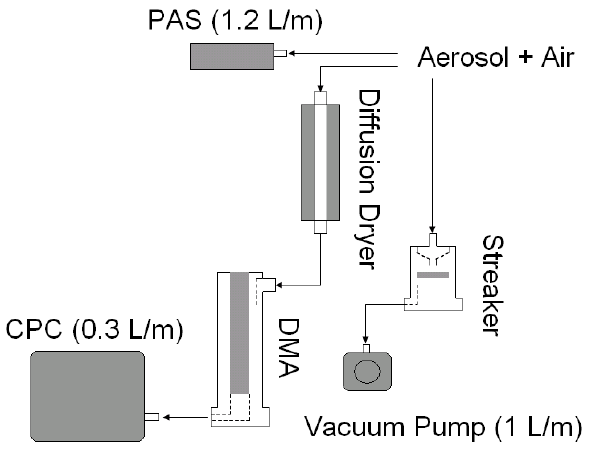
Fig. 1. Schematic of the field sampling